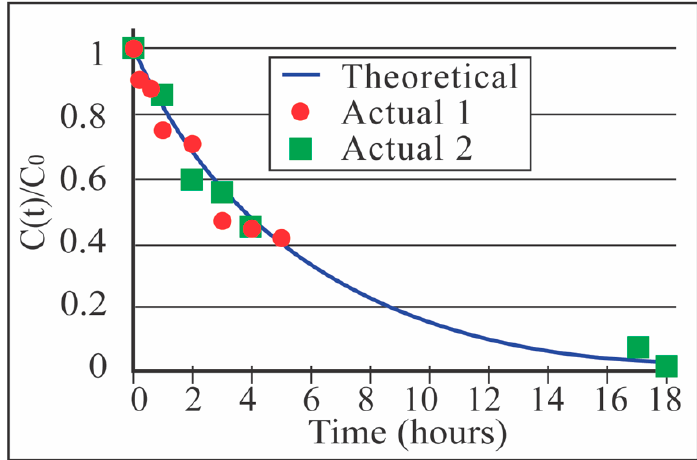
Figure 5. Comparison of the theoretical real-time urea clearance (see Equation (15)) to two multi-pass benchtop experiments with the sheet membrane device. Agreement was observed to match theory, thus showing that our model for 𝐾 = 𝑘𝑟(cid:3435)𝐴 (cid:3040)(cid:3043) 𝐴 (cid:3046)(cid:3043) ⁄ (cid:3439)𝑘𝑟𝛾 is accurate (see Equation (18)). A mp = 2.88 × 10 –4 m 2 ; A sp = 1.4 × 10 –6 m 2 . (Experiment 1: R 2 = 0.98; Experiment 2: R 2 =